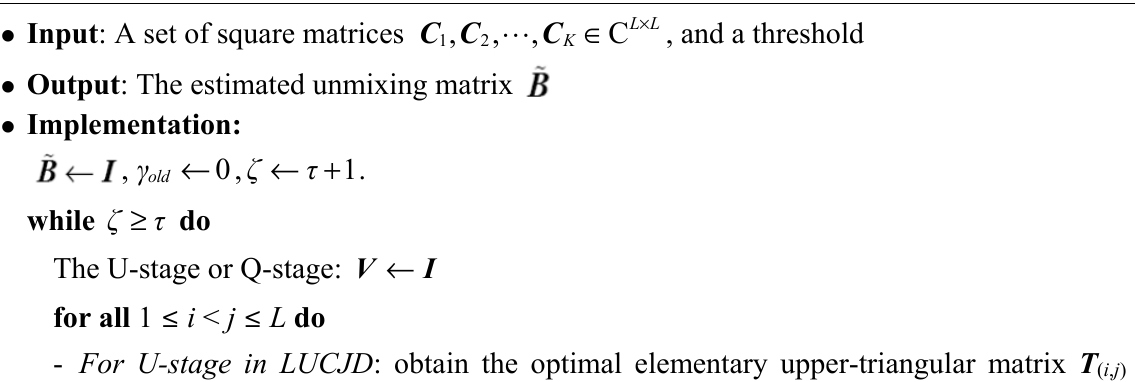
Table 1. The two proposed CNJD